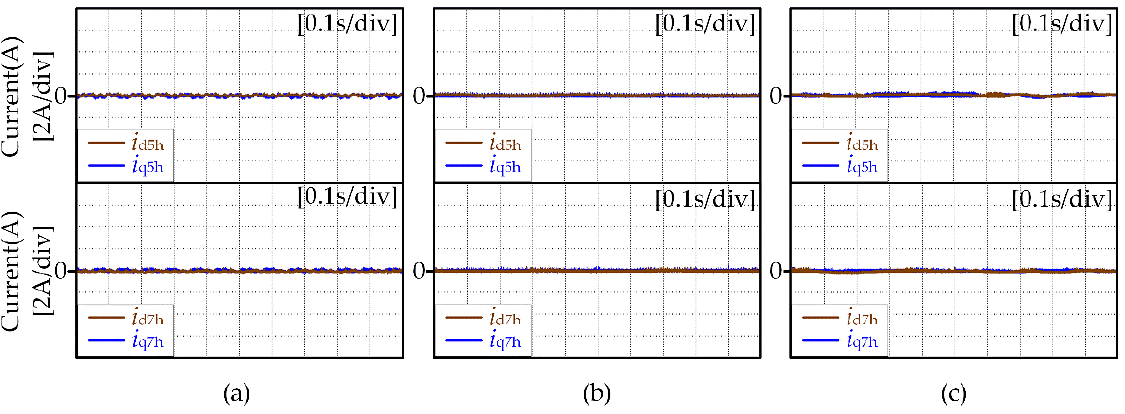
Figure 18. The steady-state waveform diagram of the 5th and 7th current harmonic components when the motor parameters change by 0.8 times. ( a ) 100 rpm; ( b ) 1000 rpm; and ( c ) 2500 rpm.